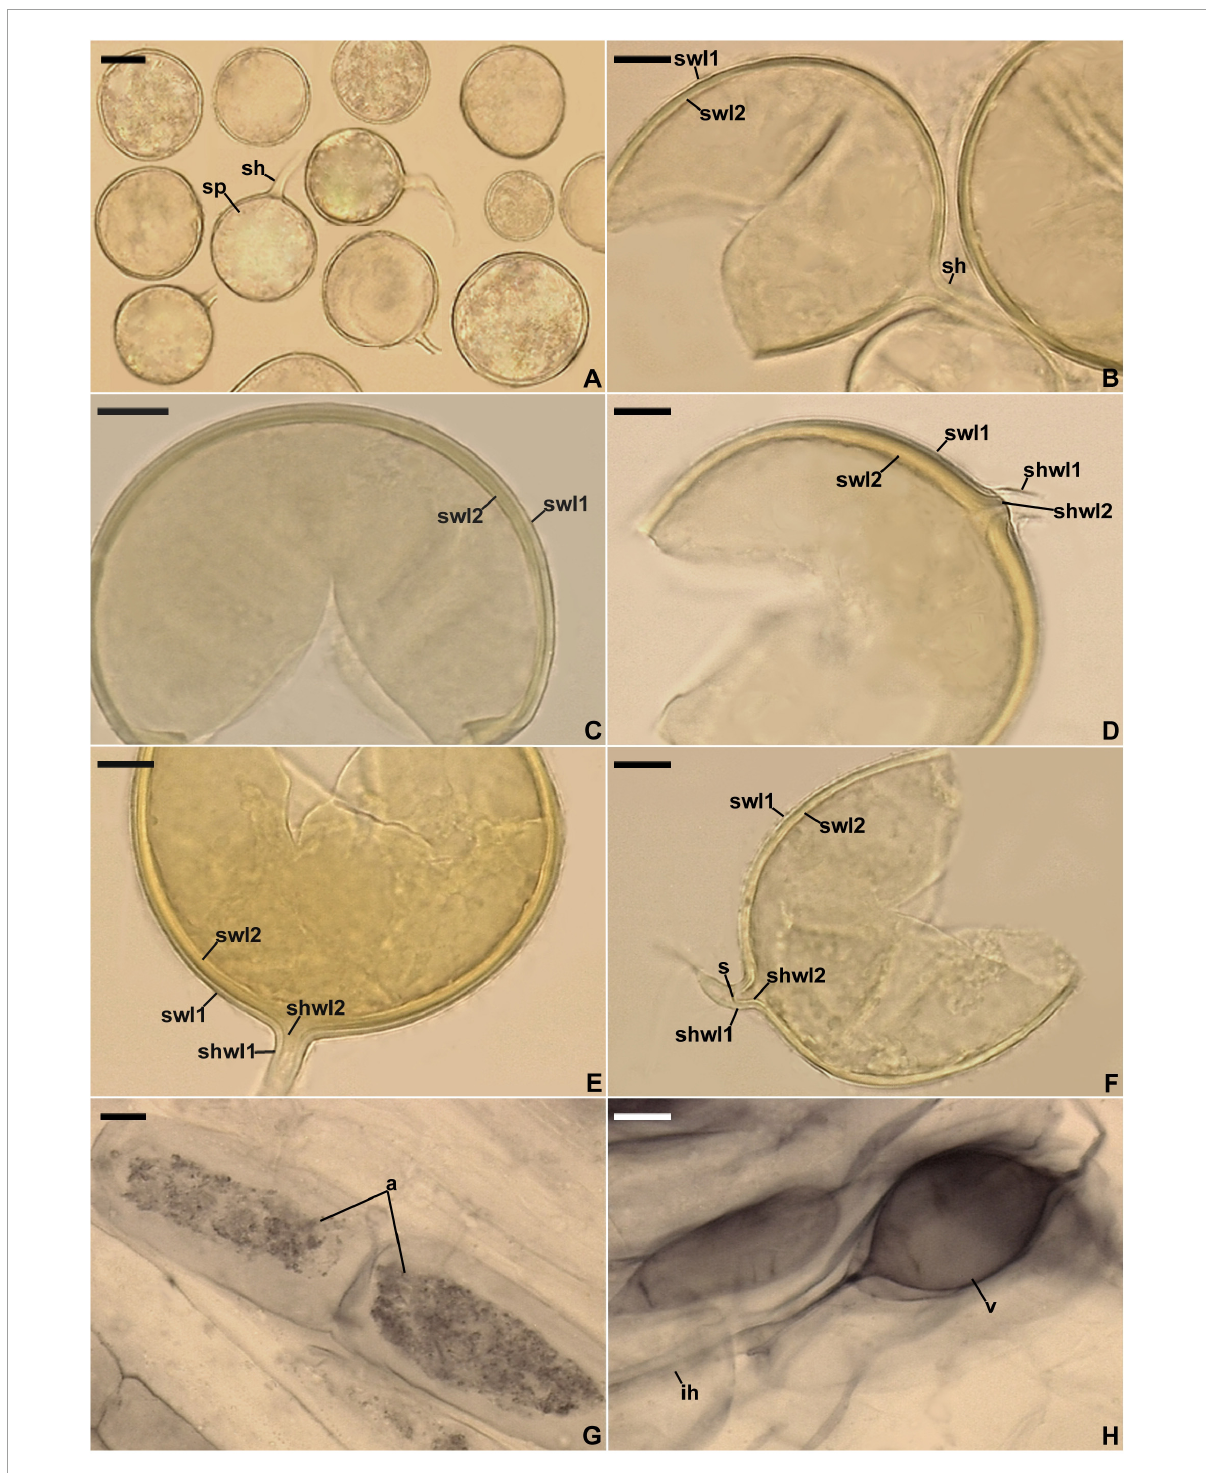
FIGURE5 Entrophospora infrequens . (A) Intact glomoid spores (sp) with subtending hyphae (sh). (B–F) Spore wall layers (swl) 1 and 2 continuous with subtending hyphal wall layers (shwl) 1 and 2; a septum (s) continuous with swl2 in the lumen of the sh is indicated in (F) . (G,H) Arbuscules (a), intraradical hyphae (ih), and vesicles (v) in roots of Plantago lanceolata stained in 0.1% Trypan blue. (A–D,G,H) Spores and mycorrhizal structures in PVLG. (E,F) Spores in PVLG+Melzer’s reagent. (A–H) Differential interference microscopy. Scale bars: (A) = 20 µ m, (B–H) = 10 µ